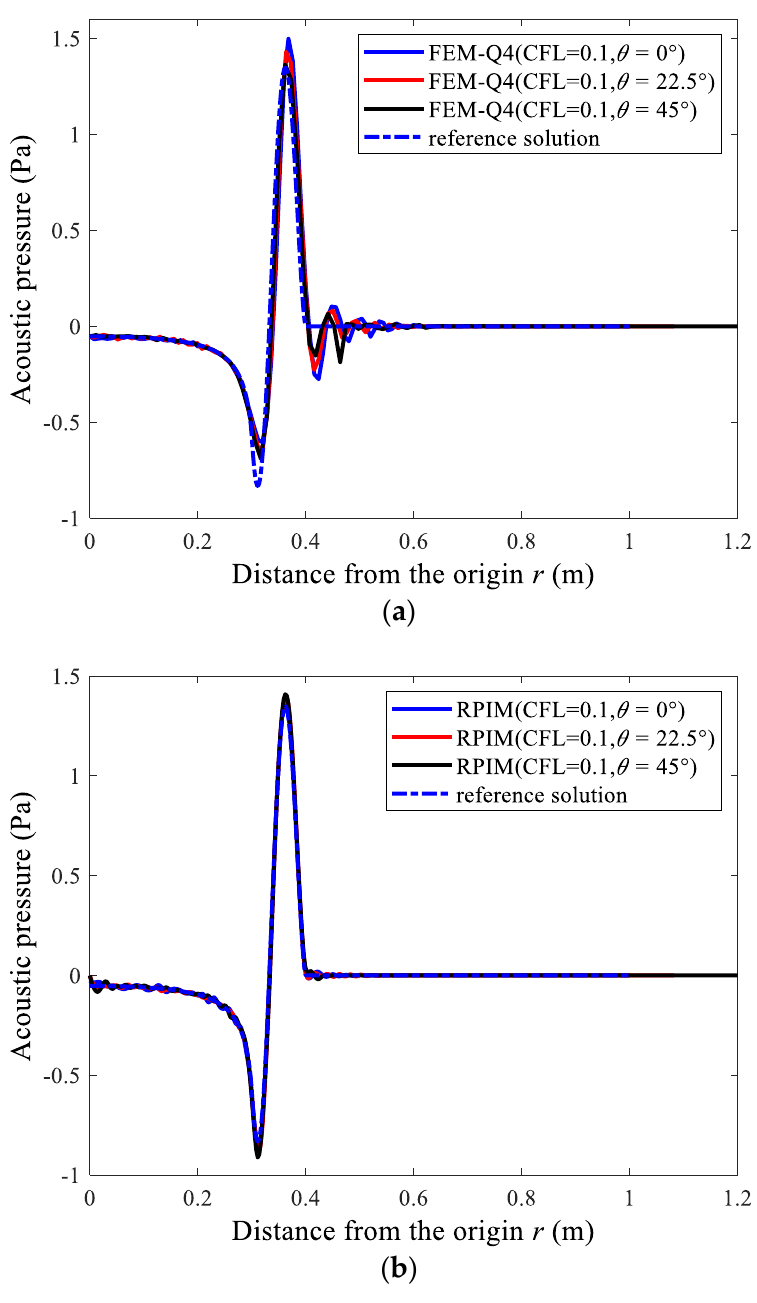
Figure 16. The transient responses of the acoustic pressure distributions from different methods for the two‑dimensional scattering problem by considering the different wave travel angles: ( a ) FEM‑Q4; ( b ) RPIM. Next, the varying non‑dimensional time integration steps (CFL = 1, CFL = 0.5, CFL = 0.25, and CFL = 0.1) are exploited in the numerical analysis to check whether the monotonic convergence property can be reached in transient wave analysis. For two different time points( t = 0.4 s and t = 0.7 s) and two different angles of wave travel ( θ = 22.5 the computed acoustic pressure distributions from different numerical techniques are pre‑ sented in Figures 17 and 18. The relevant observations from these figures are quite simi‑ lar to those found in a previous numerical experiment; in particular, the monotonic con‑ vergence numerical feature can broadly be reached by the meshfree RPIM and cannot be reached by the conventional